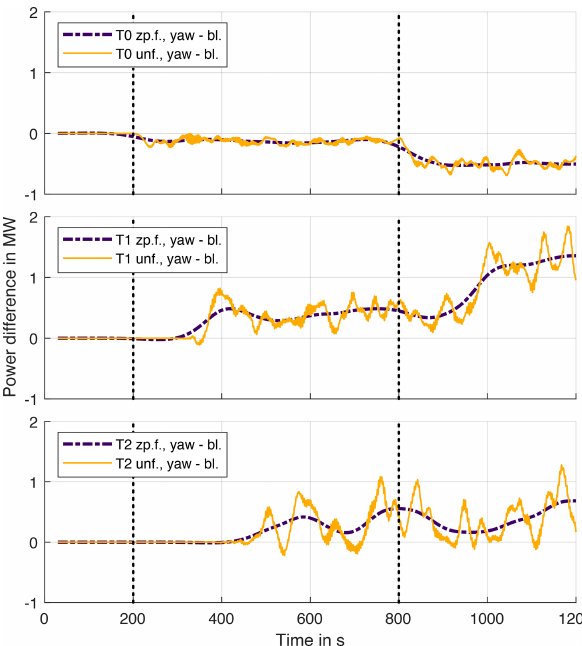
Figure A1. Difference between the yaw case in SOWFA and the baseline case with unfiltered and zero-phase-filtered data. Filtering was performed before calculating the difference. The dotted lines mark the start of the yaw angle changes of